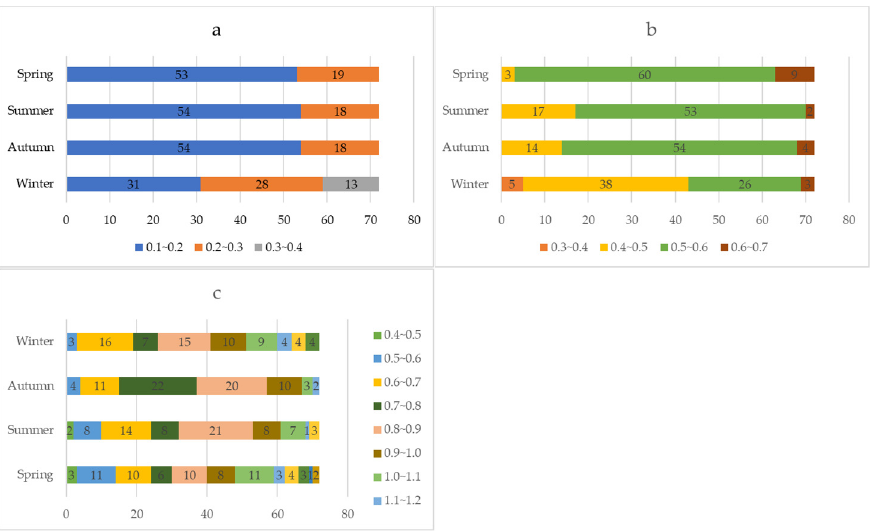
Figure 7. Distributions of the coefficient a ( a ), coefficient b ( b ) and coefficient c ( c ) for the 72 stations in the Sen Model in different seasons.